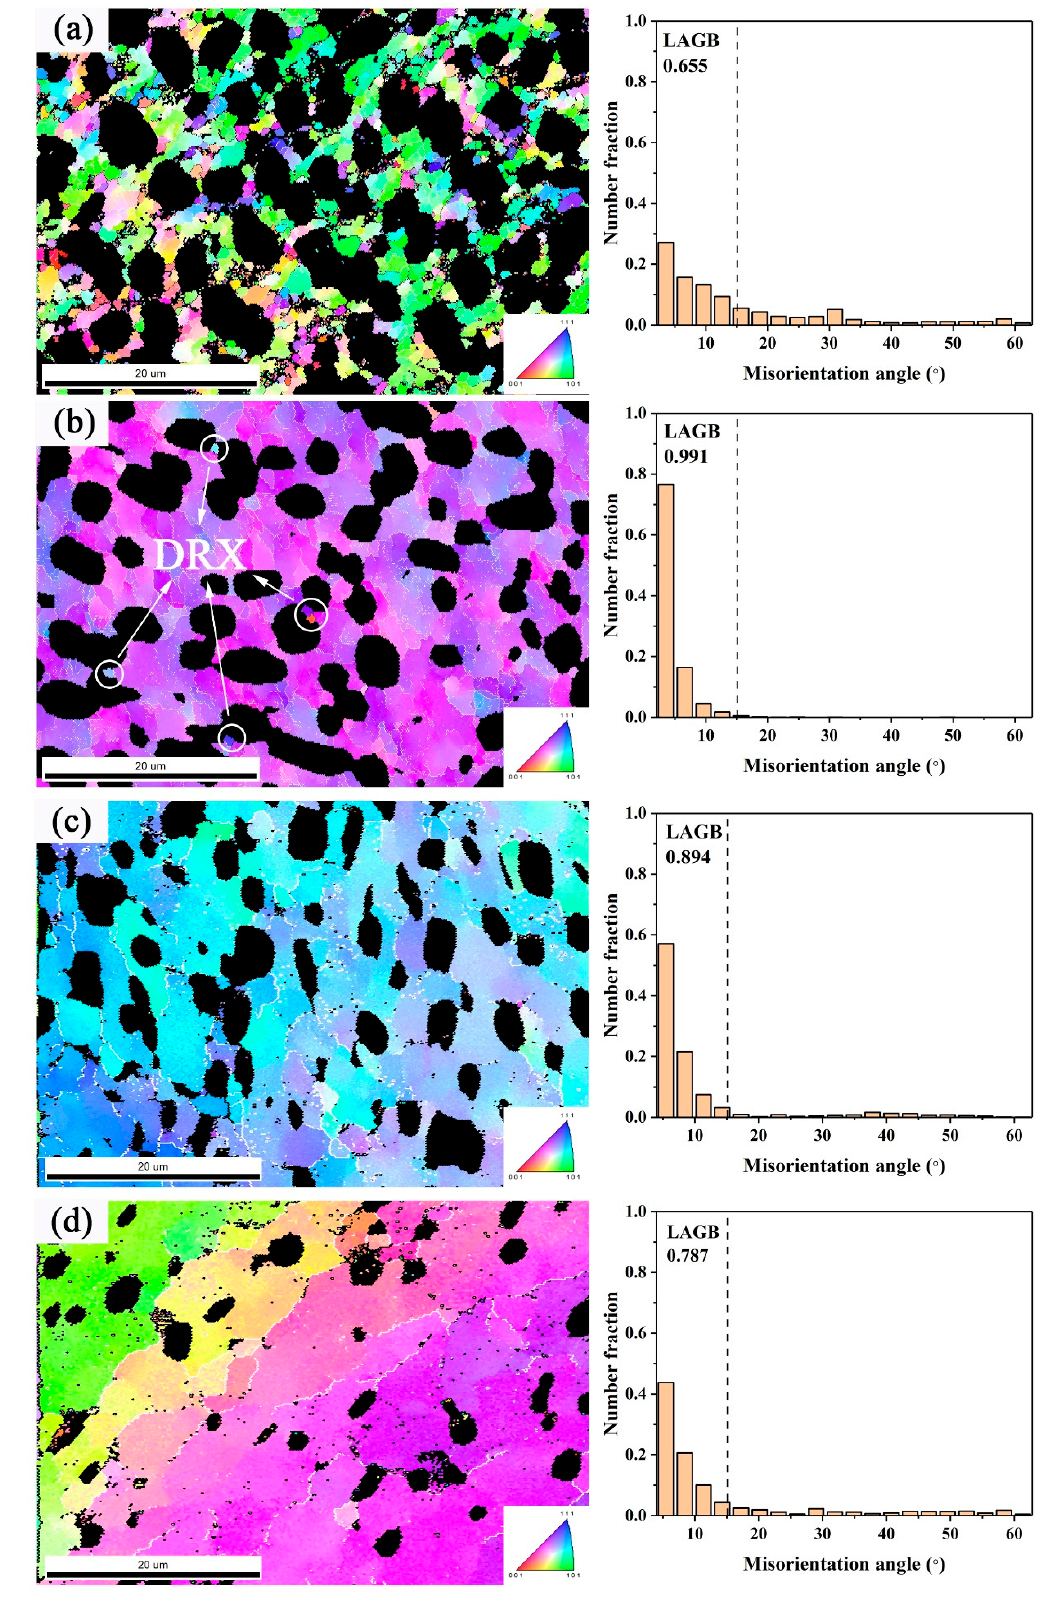
Figure 5. Inverse pole figures (IPF) figures after first-pass compression at ( a ) 700 °C, ( b ) 750 °C, ( c ) 800 °C, ( d ) 850 °C.